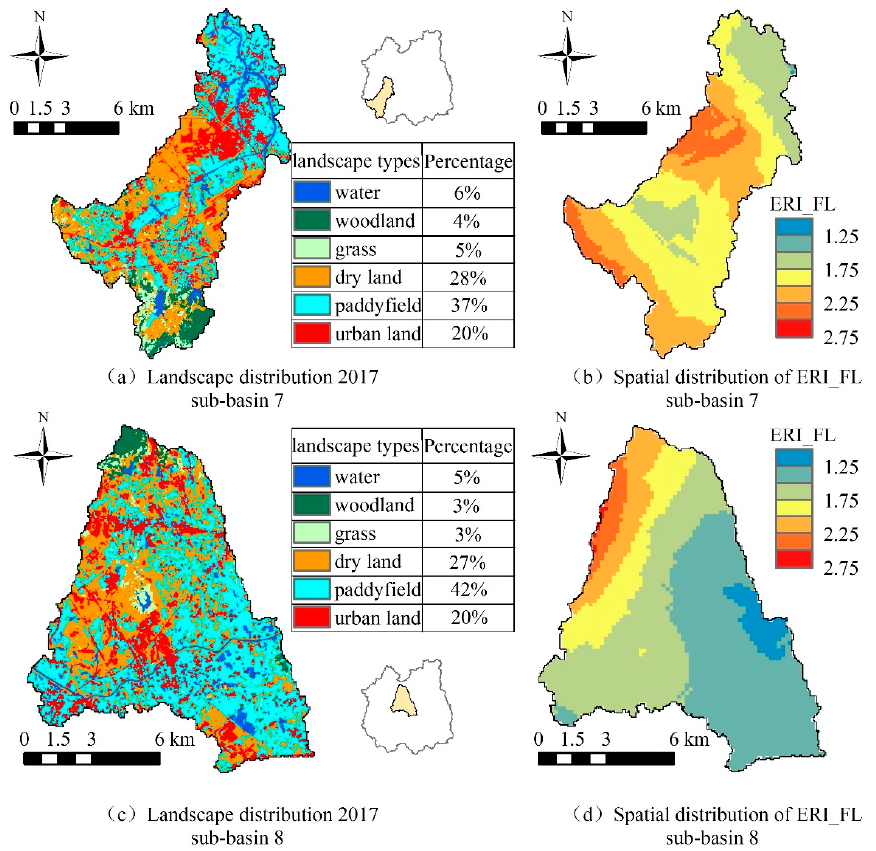
Figure 10. Landscape and FLER distributions of no. 7 and 8 sub ‐ basins.